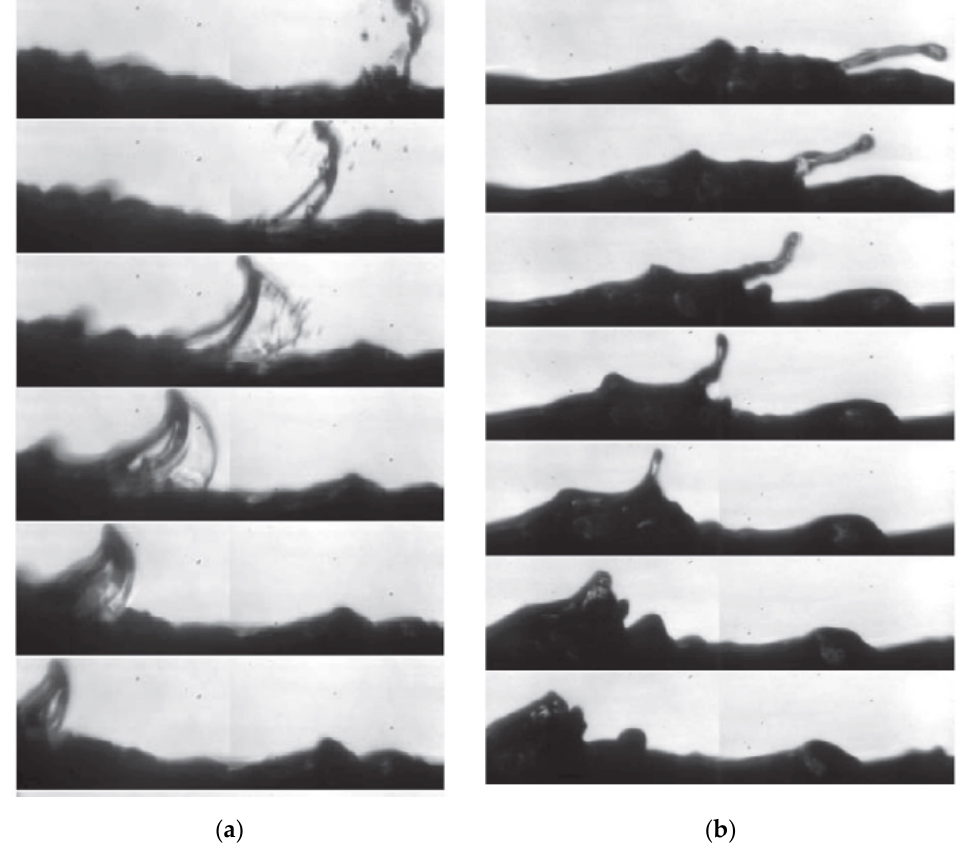
Figure 5. Visualization of entrainment due to bag break-up ( a ) and ligament break-up ( b ) on the outer surface of a vertical cylinder in the x - z plane [43].